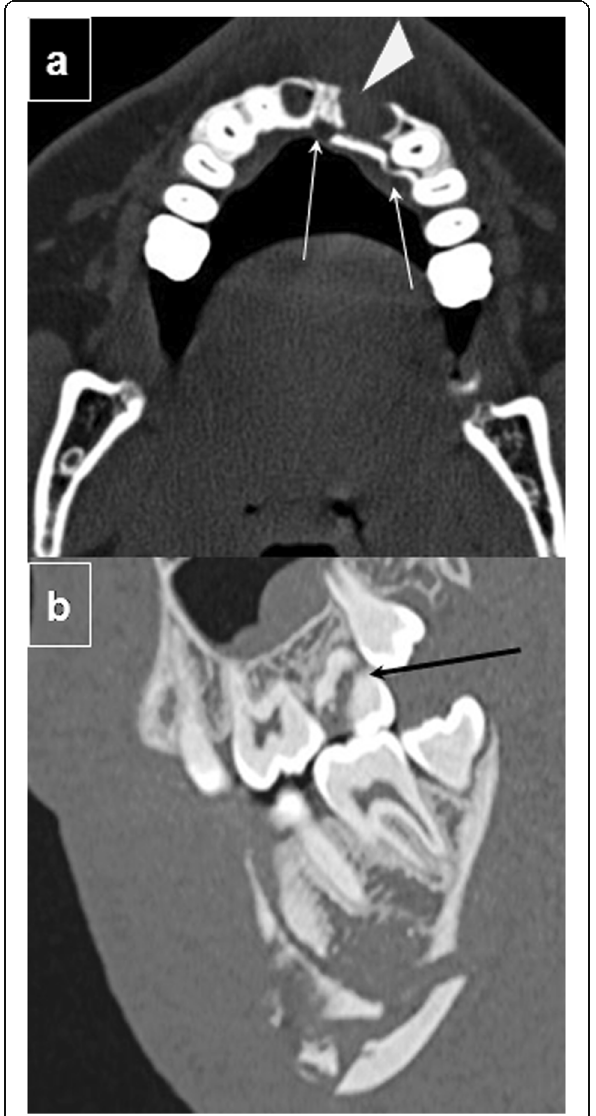
Fig. 4 Dental complications. a Axial CT image shows a fracture of the upper alveolar ridge (thin white arrows) with avulsion of the left incisors (arrowhead). b Sagittal unenhanced CT image at the level of mandibular body demonstrates a molar crown fracture (black arrow) associated with a mandibular fracture